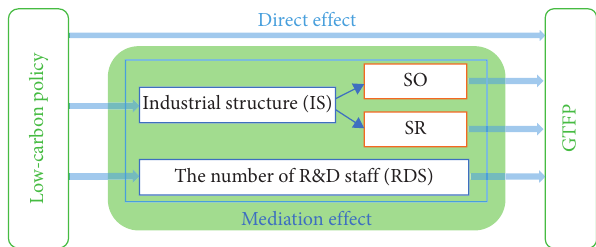
Figure 1: The influence of low-carbon policy on